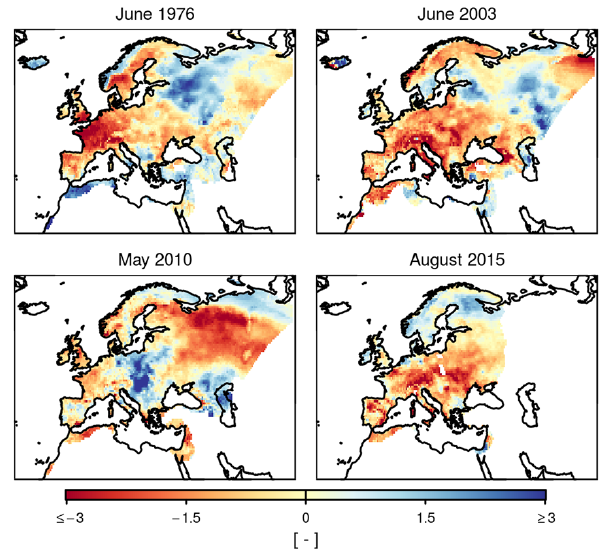
Figure 13. Standardised runoff anomalies for selected drought events in